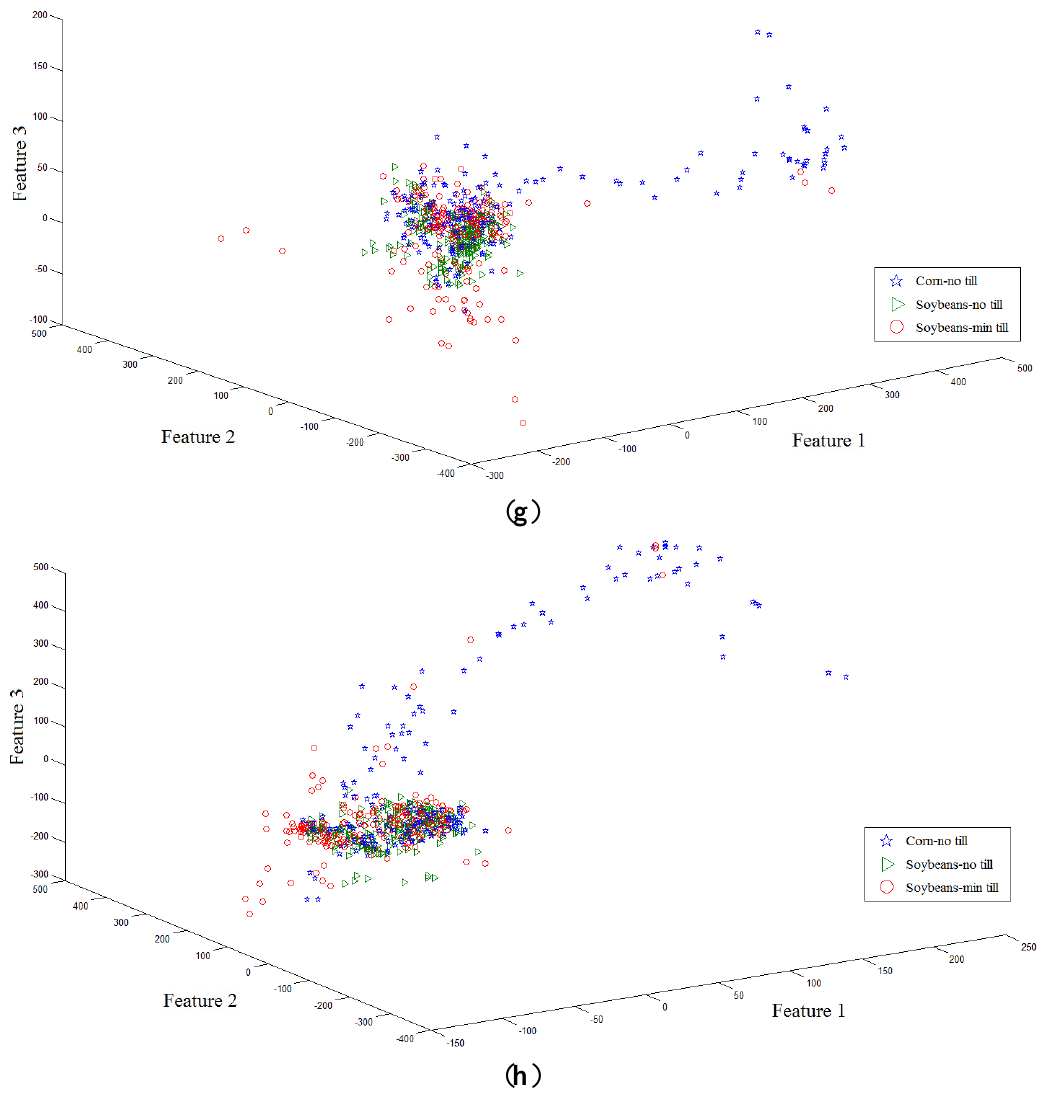
Figure 3. The second toy sample distributions projected on the first three axes using algorithms ( a ) PCA; ( b ) LDA; ( c ) supervised LPP; ( d ) LFDA; ( e ) NFLE; ( f ) FNFLE; ( g ) KNFLE; and ( h )